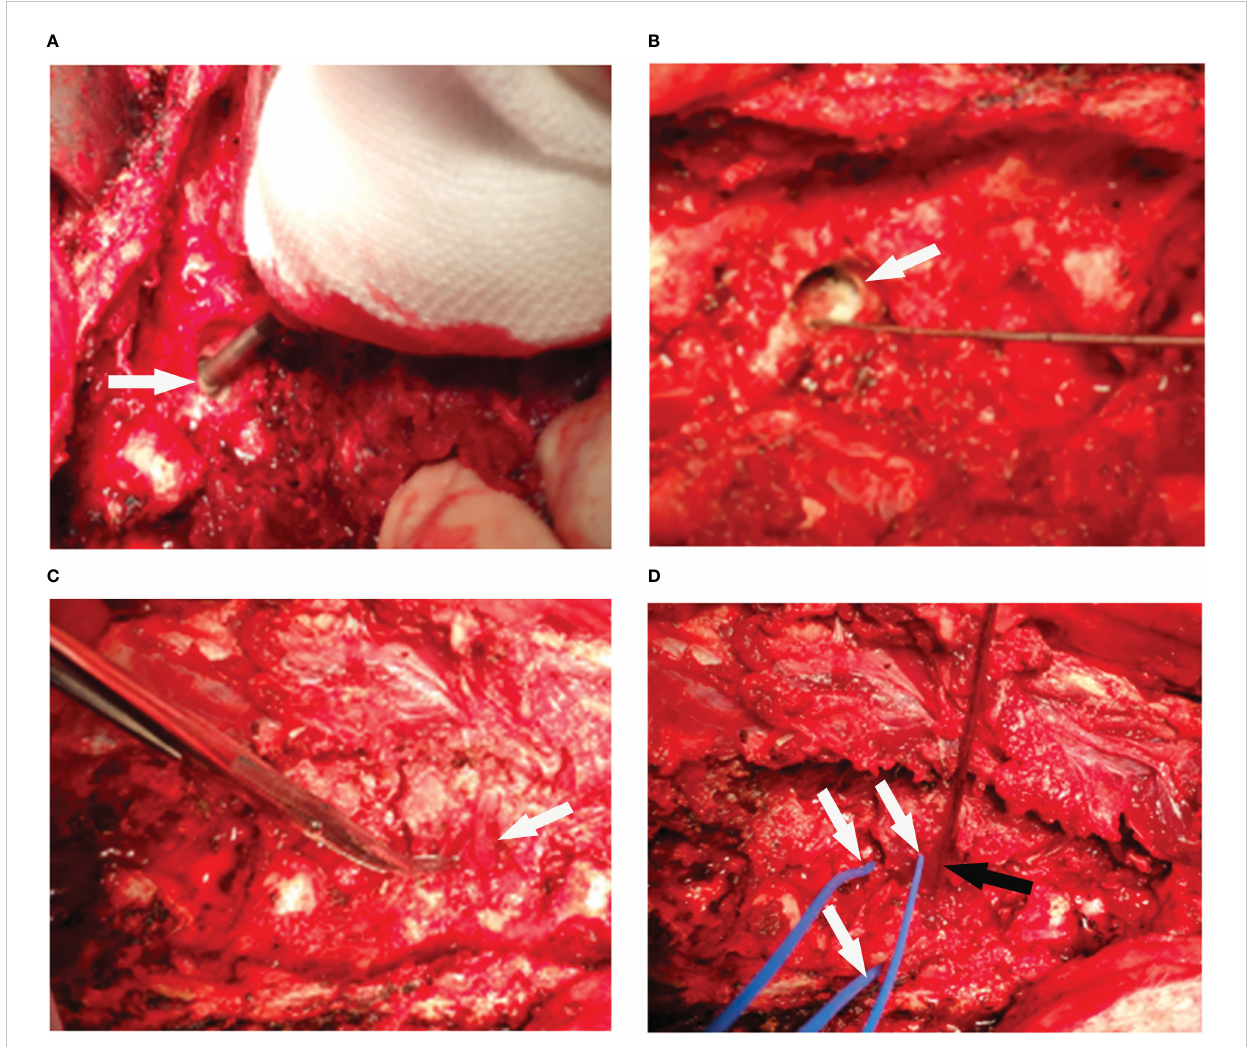
FIGURE 6 The process of making a vertebral tumor model. (A) The holes were drilled through the pedicle of vertebral with a grinding drill (arrow). (B) The cavity was made in vertebra (arrow). (C) The adjacent muscle fl ap was separated (arrow), and the vascularized muscle fl ap was used to fi ll the vertebral cavity. (D) Radiofrequency ablation was performed in the vertebral tumor model (black arrow), and the temperature of the peripheral spinal cord, nerve root foramen, and anterior edge of vertebra were monitored (arrows) in real